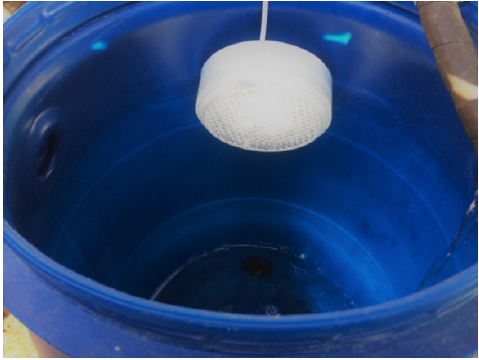
Figure 19. The operation of the LED lamp due to the converted thermal energy of the anode gases.